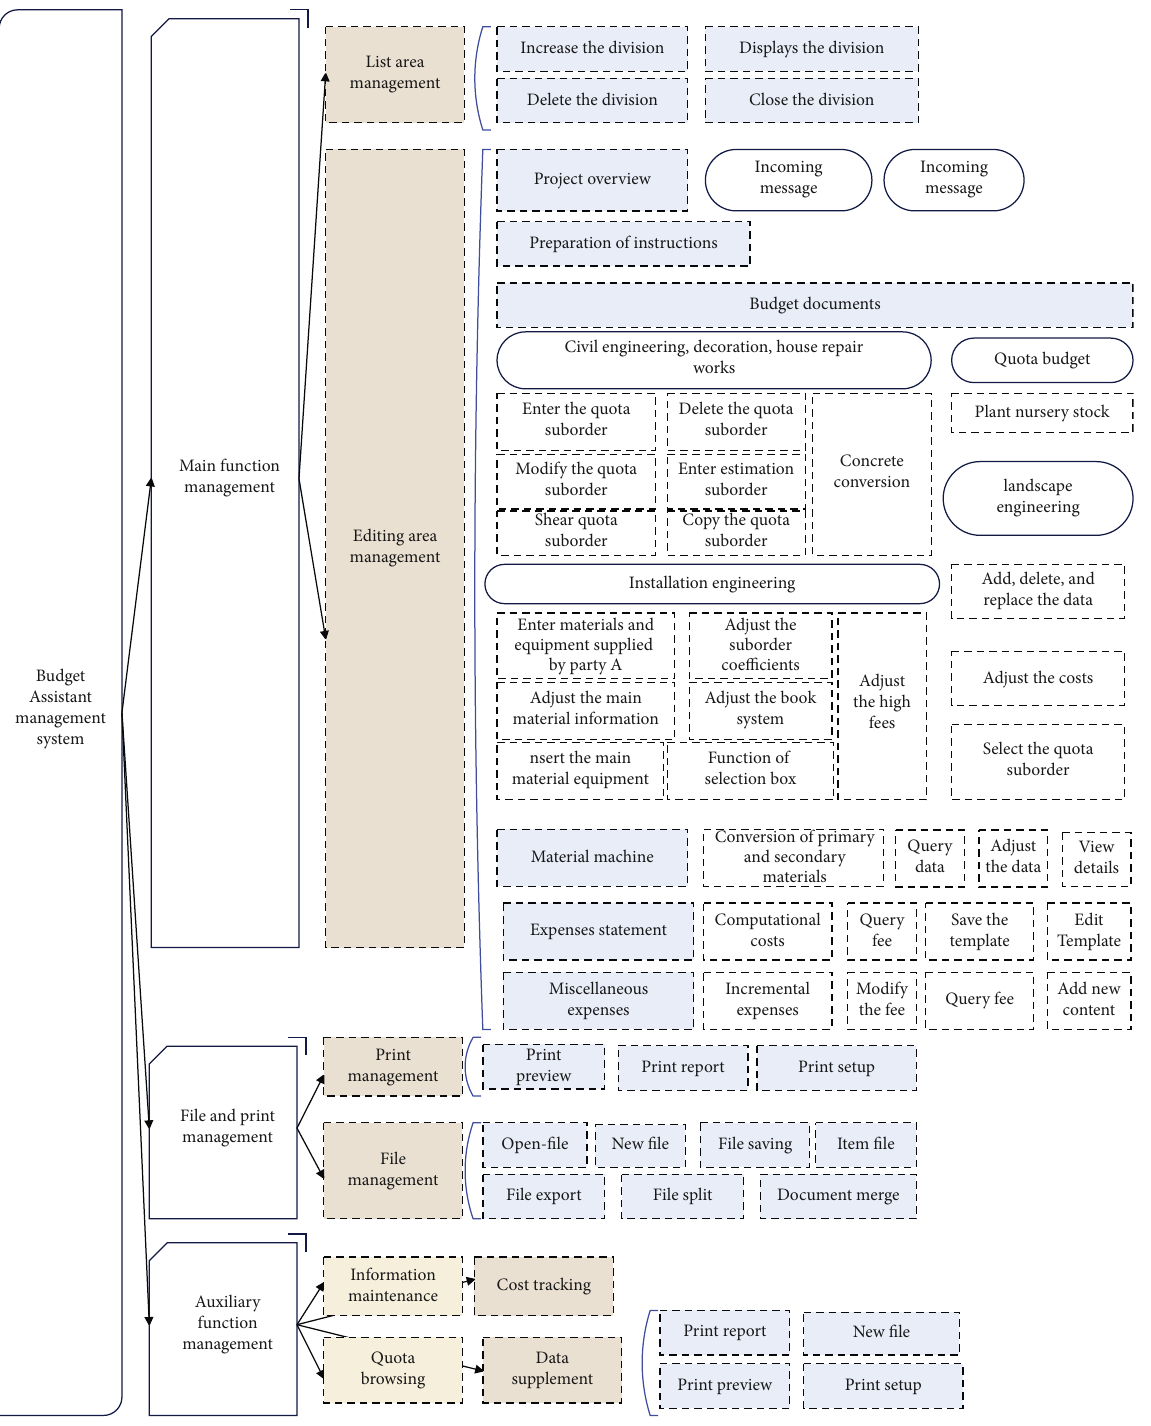
Figure 7: System function structure